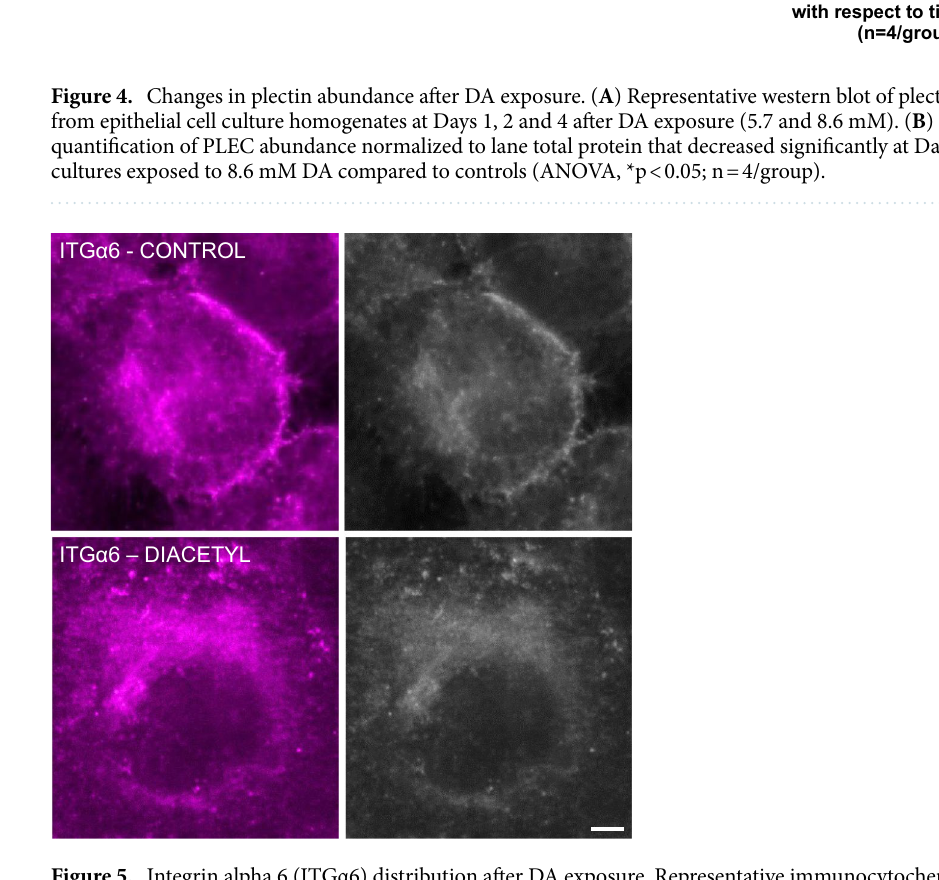
Figure 5. Integrin alpha 6 (ITGα6) distribution after DA exposure. Representative immunocytochemistry images of ITGα6 in control cells (top) and DA- exposed cells (bottom) at Day 4 (scale bar: 10 μm). In controls cells, ITGα6 expression localized primarily to the cell membrane. In DA-exposed cells, ITGα6 expression localizes primarily within the